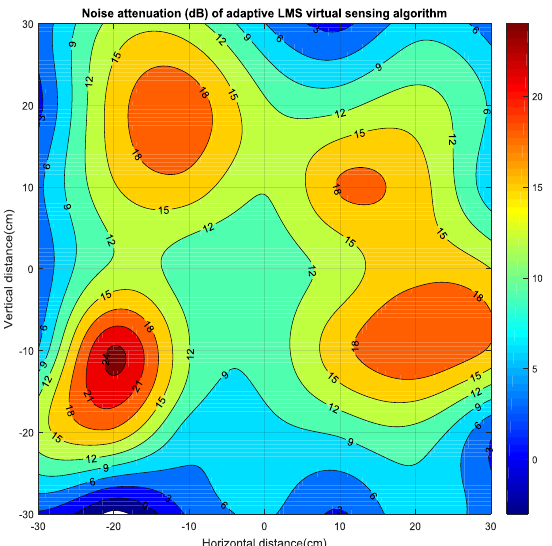
Figure 9. The quiet zone generated by multichannel ANC with the adaptive LMS virtual sensing algorithm in the varying environment. Electronics 2017 , 6 , 76 10 of 12